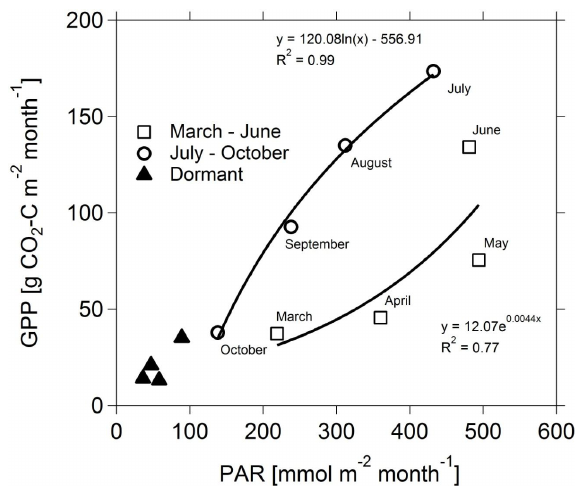
Figure 3. Hysteresis in gross primary production (GPP) as a func- tion of photosynthetically active radiation (PAR) (10-year monthly means). Table 1. Spearman’s rank correlation coefficients ( ρ ) and associ- ated p values for all statistically significant inter-annual correlations between ecosystem response and hydro-meteorological parameters observed at Auchencorth Moss during the study period 2003–2013. The suffix SS denotes spring/summer means and LGS is the length of the growing season. GPP sat and α are GPP at light saturation and quantum efficiency, respectively, obtained by non-linear regression between GPP and PAR using Eq. (3).